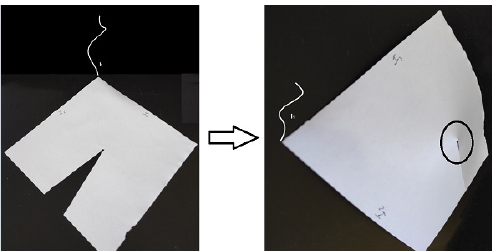
Figure 3. The vibrating string from the “puncture” (missing point) splits the underlying manifold ( I × I ) / { P } , creating a missing sector with an arbitrary small angle µ ; a wedge is cut of it. To 2 3 preserve the topological properties, the sides of the wedge glue together to create a conical defect without a